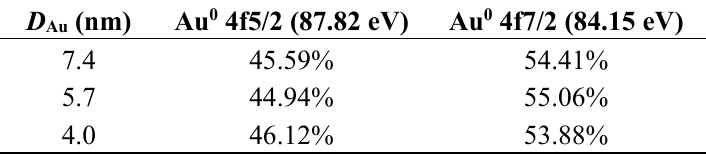
Table 2. Oxidation states of the Au on the Au-TiO 2 photocatalysts prepared by the CRIS